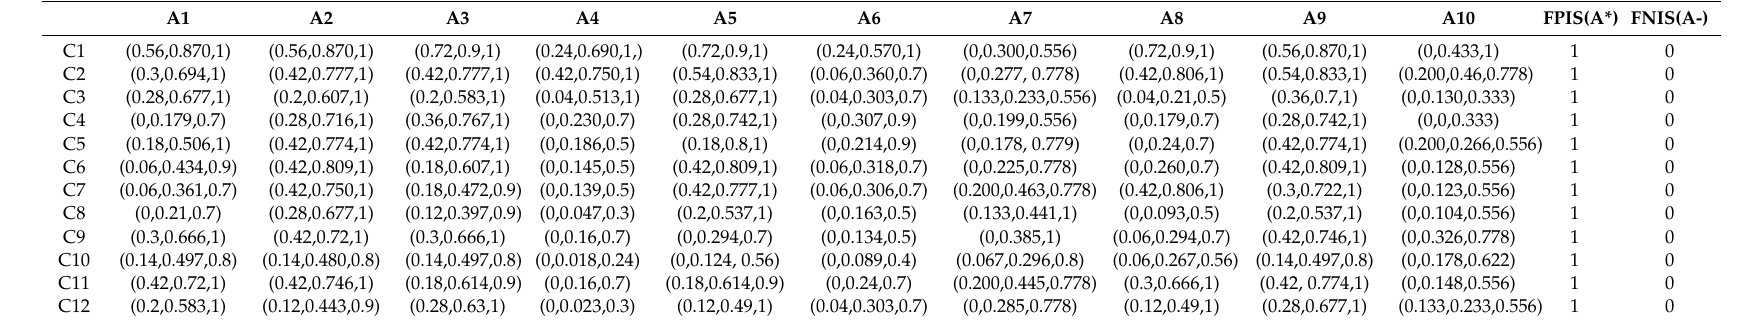
Table 13. Weighted normalized